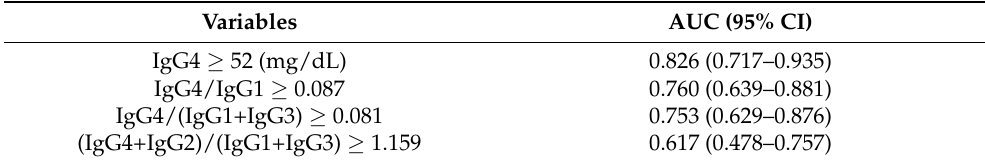
Table 5. Area under the curve of serum IgG subclass combinations for the differentiation of IgG4-SC from